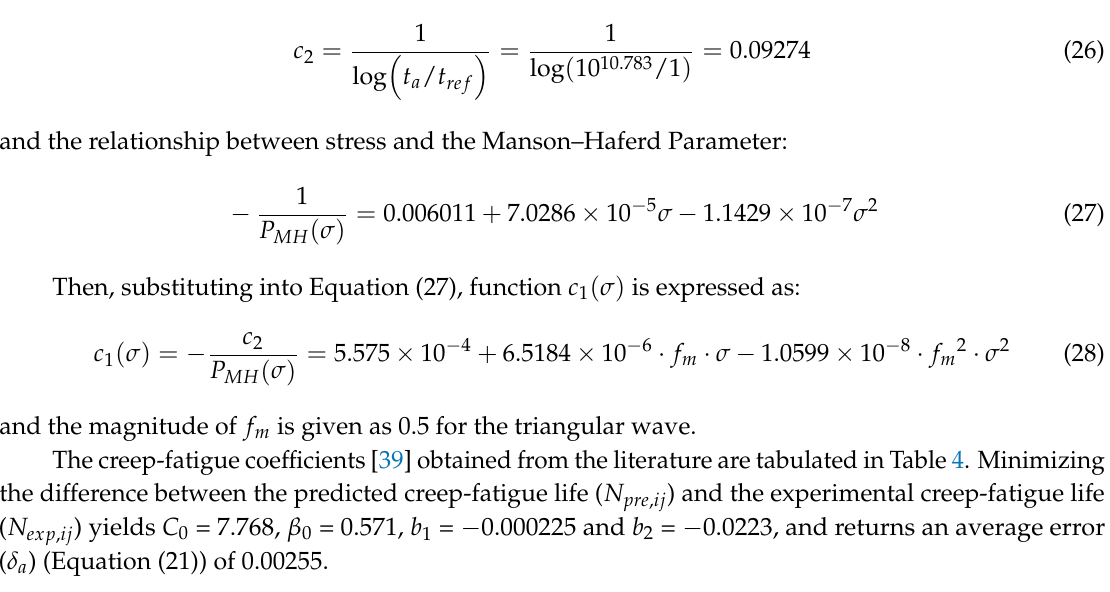
Figure 5. Prediction ratio for stainless steel 316.